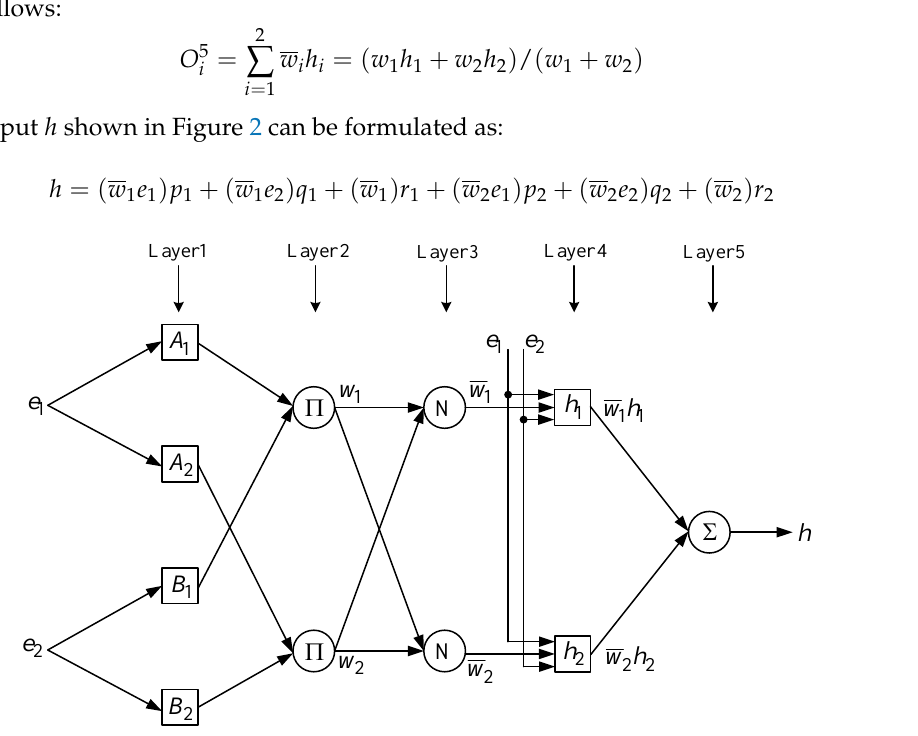
Figure 2. Architecture of the adaptive neuro-fuzzy inference system (ANFIS) ( i e : input,